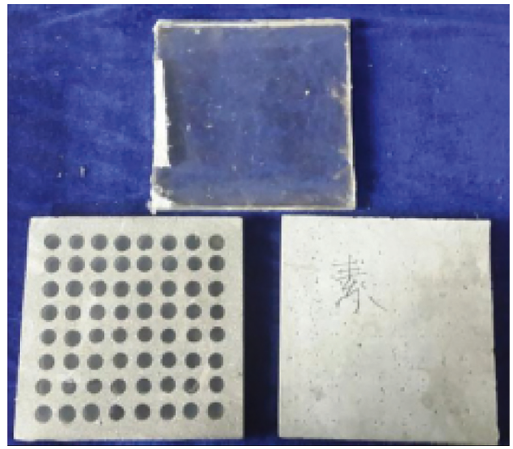
Figure 15: Panels needed for the